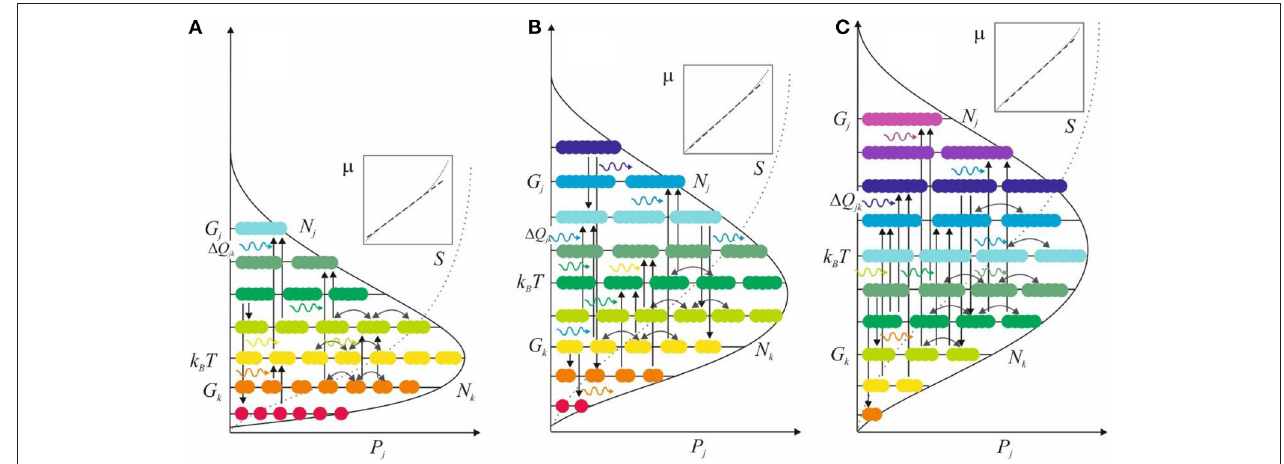
FIGURE 1 | System is portrayed in terms of an energy level diagram along its evolutionary path at three states (A–C). Each diagram pictures various populations N k of entities, each with energy attribute G k . Vertical arrows indicate paths of transformations, i.e., changes from k -entities in the population N k to j -entities in the population N j . Horizontal wavy arrows denote influx and efflux of photons that invariably couple to these transformations. Horizontal bow arrows, in turn, mean inconsequential exchange of indistinguishable entities. The system evolves, step-by-step, via absorptive and emissive jk -transformations from one state to P j , eventually arriving at a stationary-state balance where its average energy k B T equals energy another toward ever more probable partitions, denoted by P = density in the system’s surroundings. The outlined skewed partition accumulates along a sigmoid curve (dotted) which follows mostly a straight line on a log-log scale Q (insert) for entropy S = k B ln P vs. [chemical] potential energy µ